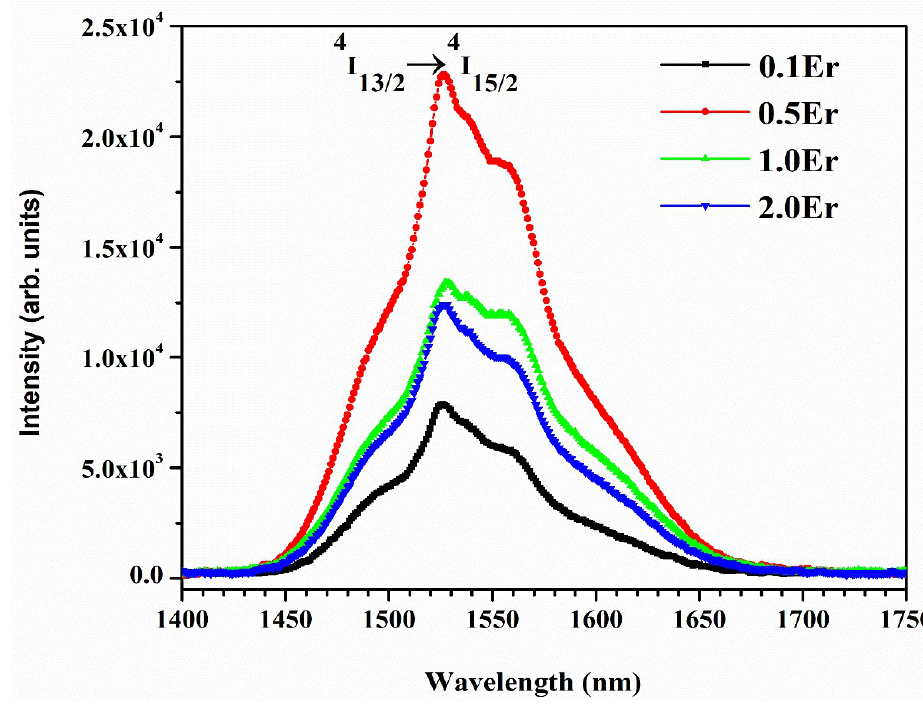
Figure 5. Near ‒ infrared emission spectra of Er 3+ doped ZBB glasses. Figure 5. Near-infrared emission spectra of Er 3+ doped ZBB glasses. Table 4. Radiative properties for 4 I 13/2 → 4 I 15/2 of Er 3+ ions doped ZBB glasses along with other reported